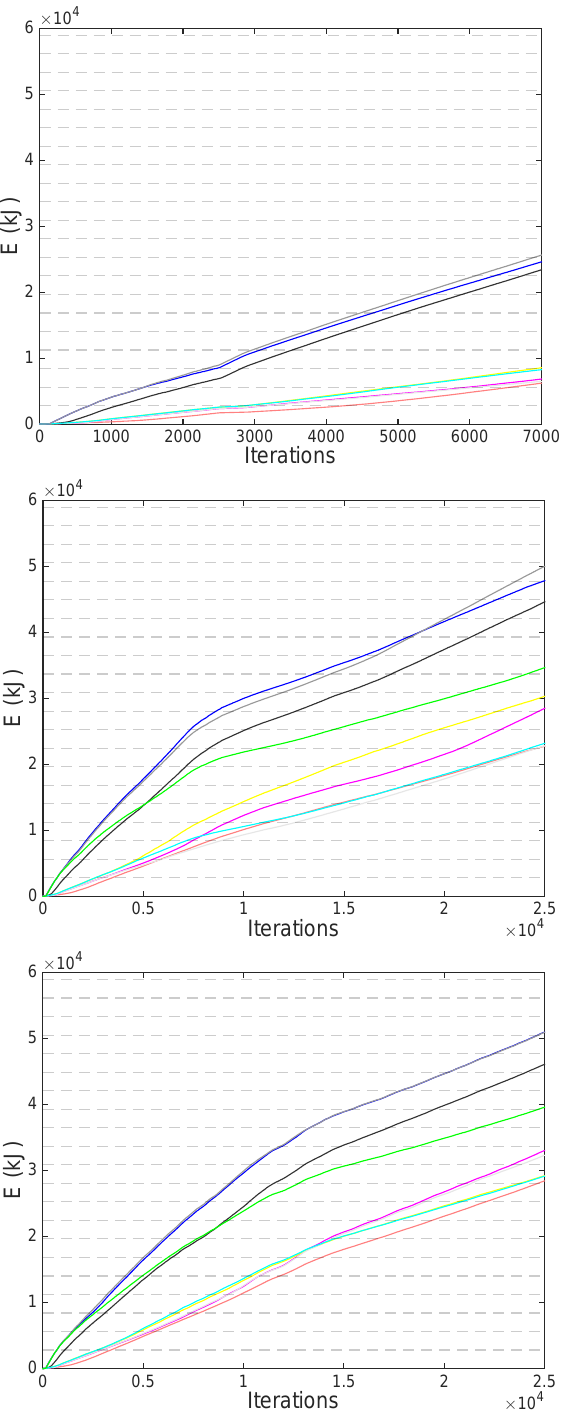
Figure 10. Evolution of the individual energy consumptions vs the numbers of iterations for: one UAV decays ( top ); displacement of users ( center ); and scattering of users ( bottom ). Each color in the figures represents one UAV using the same colors as the ones assigned to letters in the previous figures in this